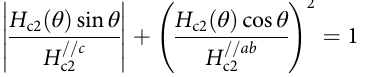
In comparison, the experimental data clearly deviates the curve of 3D model == ab = 2 ; γ ¼ = H == c cos 2 θ Þ 1 H around θ = 90°, as shown in the c2 c2 upper inset of Fig. 4e, unambiguously showing the SC of AuTe 2 Se 4/3 is quasi-2D nature. The SC of AuTe 2 Se 4/3 was examined by the magnetic susceptibility ( χ ) in the low-temperature range. Figure 4f plots the temperature dependent χ of AuTe 2 Se 4/3 in zero- fi led cooling (ZFC) and fi eld-cooling (FC) mode under 10 Oe. The diamag- netic signals are observed below 2.78 K. The superconducting volume fraction is estimated to be 90% at 1.8 K. The different ffiffiffiffiffiffiffiffiffiffiffiffiffiffiffiffiffiffiffi ð 2 Þ magnitudes of χ under H // ab and H// c modes indicate a strong anisotropy of AuTe 2 Se 4/3 single crystal. The magnetization curves